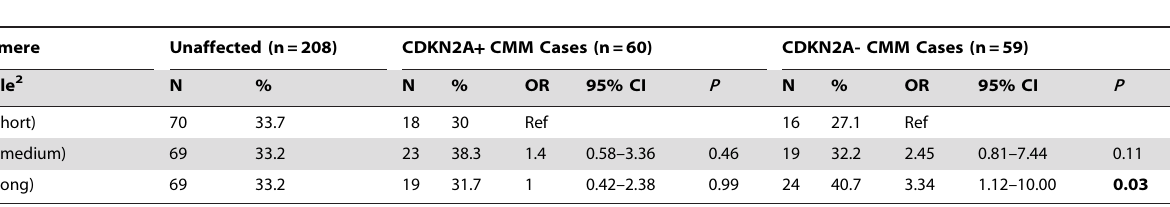
Table 4. Association of telomere length with melanoma in 53 melanoma-prone families, stratified by CDKN2A status among cases 1